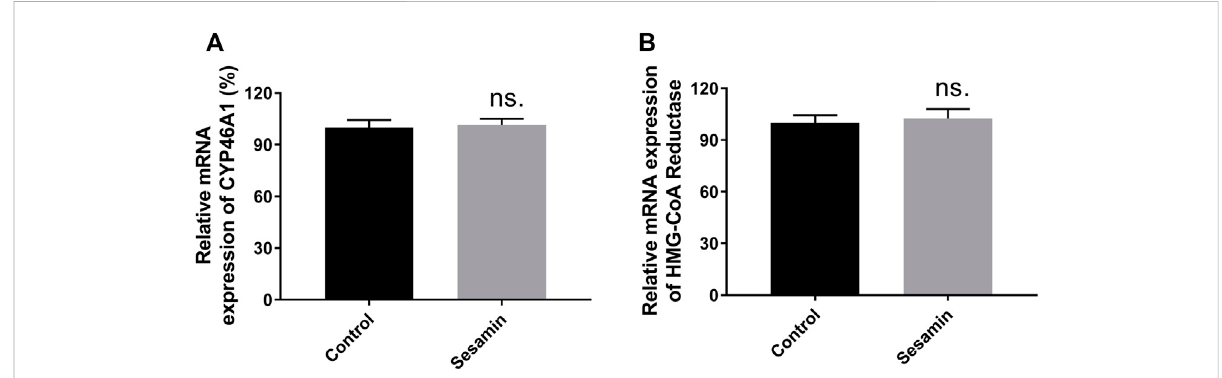
FIGURE 10 mRNA expression changes in CYP46A1 (A) and HMG-CoA Reductase (B) mRNA in rat brain tissues after treatment with sesamin. Data were analyzed byone-way ANOVA andunpairedt-testsandarepresentedas mean± SDfrom fi veexperimentscarriedout induplicate. ns: notsigni fi cant ( p > 0.05 compared with